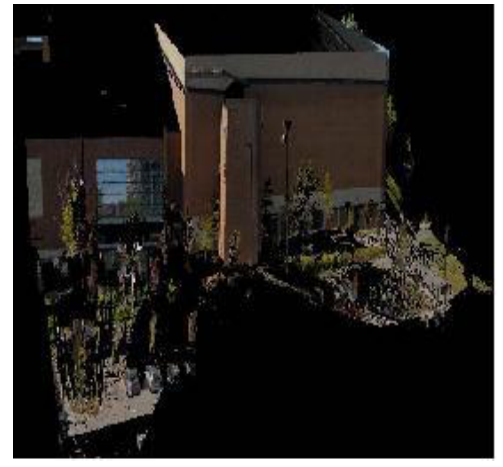
Fig.12. Textured point cloud model with laser and Images. (Source- Ming et al.,